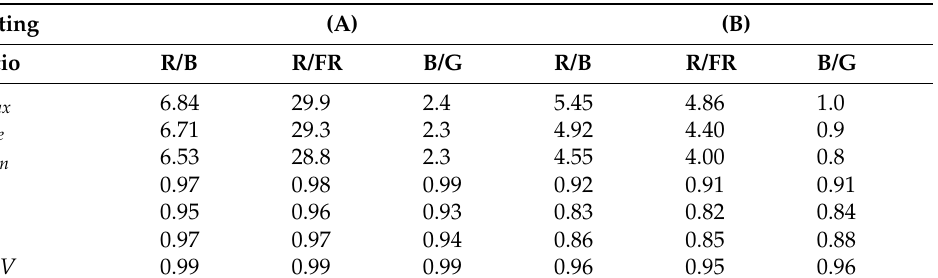
Table 2. Statistics calculated for photon irradiance ratios R/B, R/FR and B/G in case of illumination settings (A),(B).